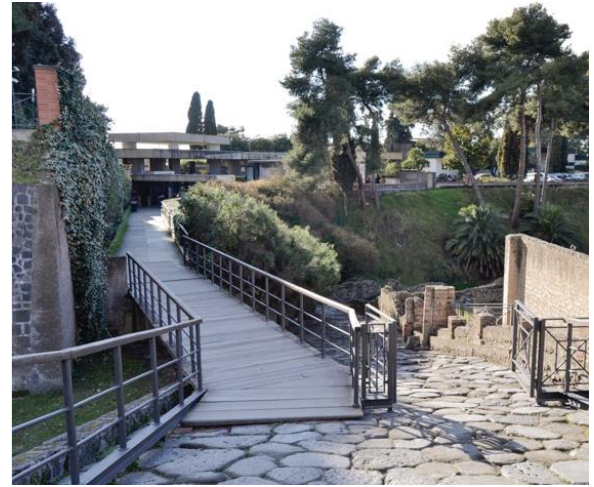
Figure 5. The wooden walkway “crosses” the Thermal